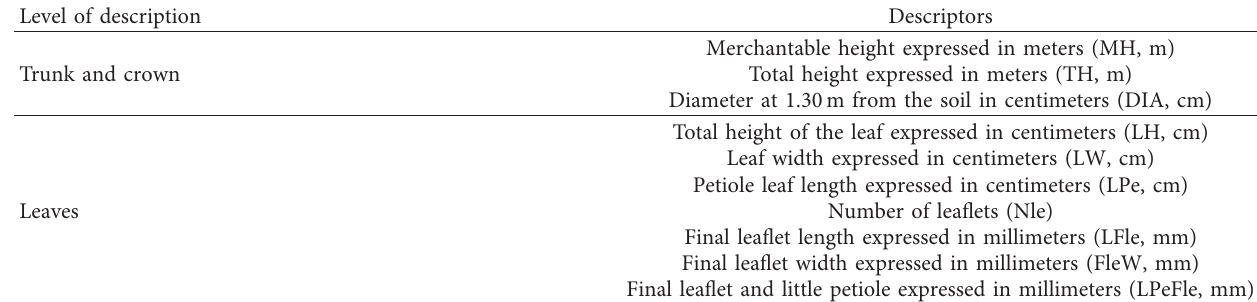
Table 3: Leaf and dendrometric descriptors.